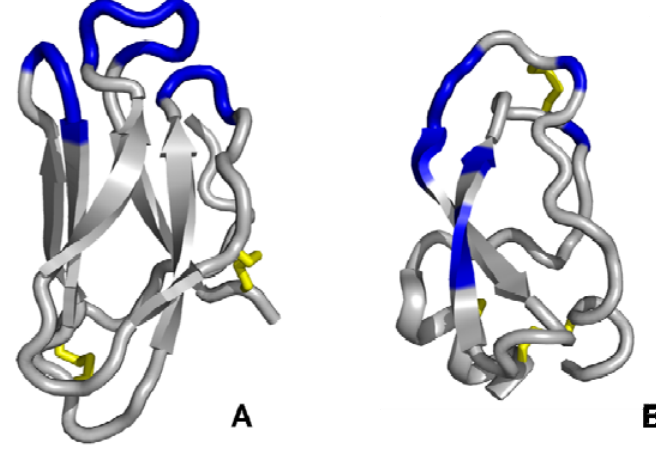
Figure 5. Schematic representations of tendamistat (A) and the Kunitz-domain scaffold (B). The discontinuous surface domains form a coherent interface for the target interaction (coloured in blue, disulfide bridges are coloured in yellow). The structural data (PDB ID: (A): 1OK0; (B): 1AAP) were illustrated using PyMol software